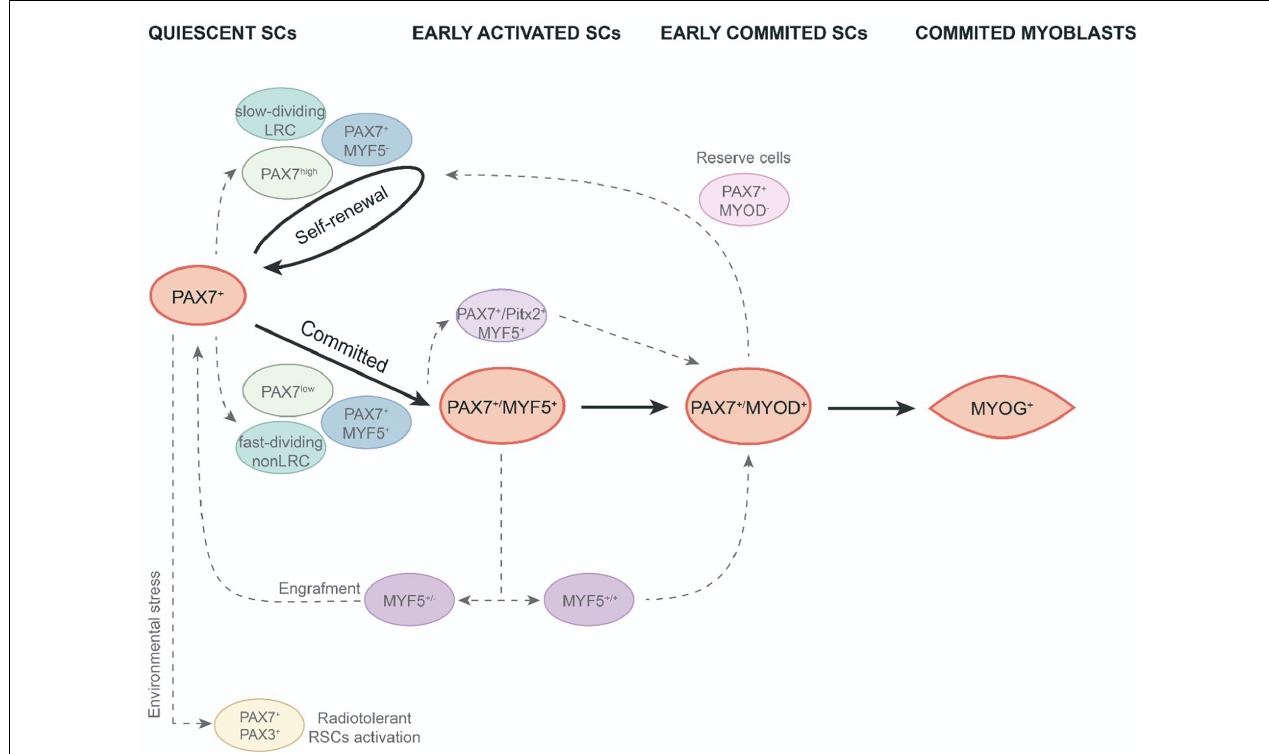
FIGURE 1 | Functional heterogeneity in adult satellite cell population. SCs activation and myogenic differentiation during adult muscle regeneration (black arrows). SC heterogeneity in the course of quiescence, early activation and early commitment of adult SCs (discontinued gray arrows). LRC, label-retaining cells; non-LRC, non-label-retaining cells; RSCs, reserve stem cells; SCs, satellite